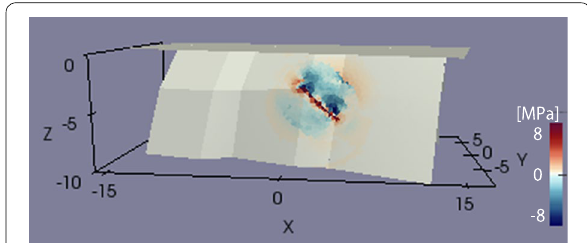
Fig. 8 Transient Coulomb stress change at 0.75 s after the rupture onset. Large positive values appear along the intersection to Fault F located behind the primary fault. View from east